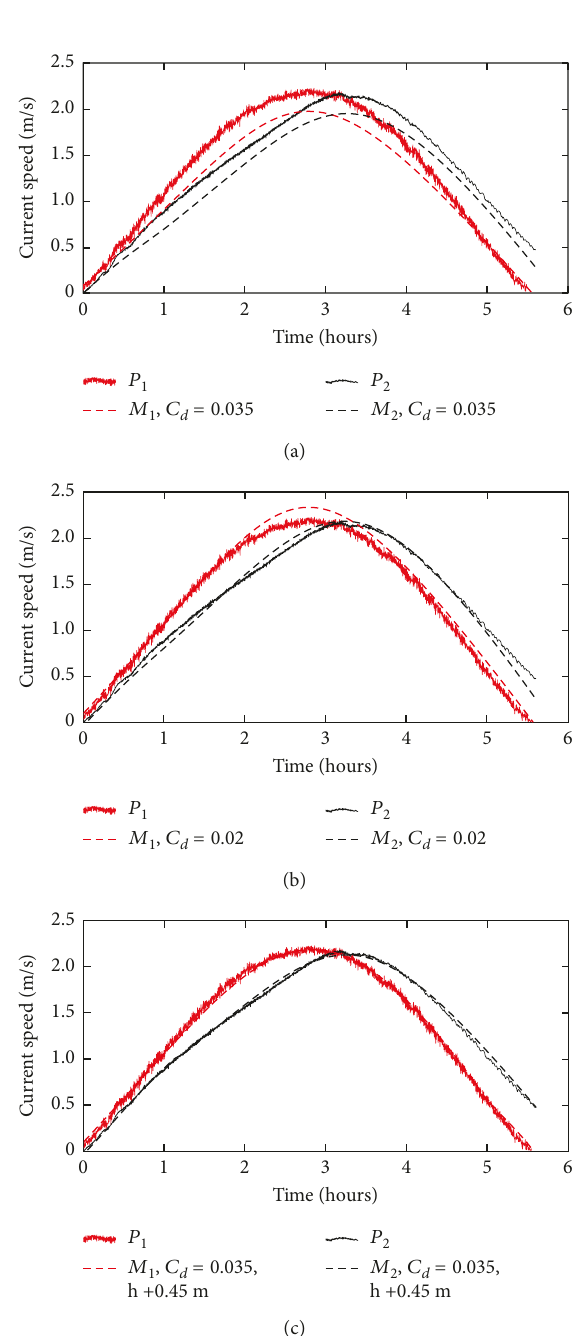
Figure 4: Simple examples of a hydrodynamic model calibration: (a) measured ( P 1 and P 2 ) and predicted ( M 1 and M 2 ) water levels at two locations with C d set to 0.0035 in the model; (b) the same plot as (a) with C d (cid:31) 0.002; and (c) the same plot as (a) with the bathymetry corrected by +0.45